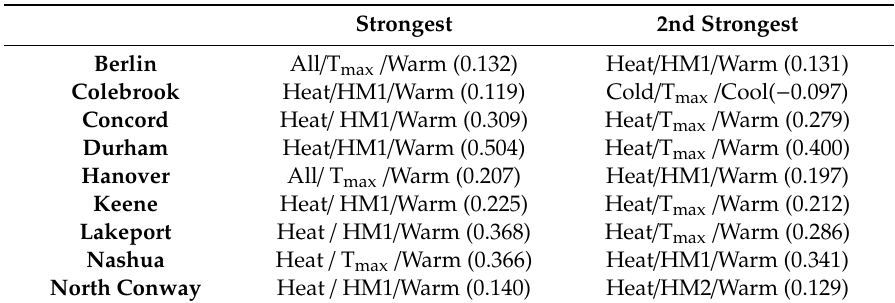
Table 7. Strongest seasonal correlations for each study area with the outcome variable listed first and the exposure variable listed second (season listed third as Warm or